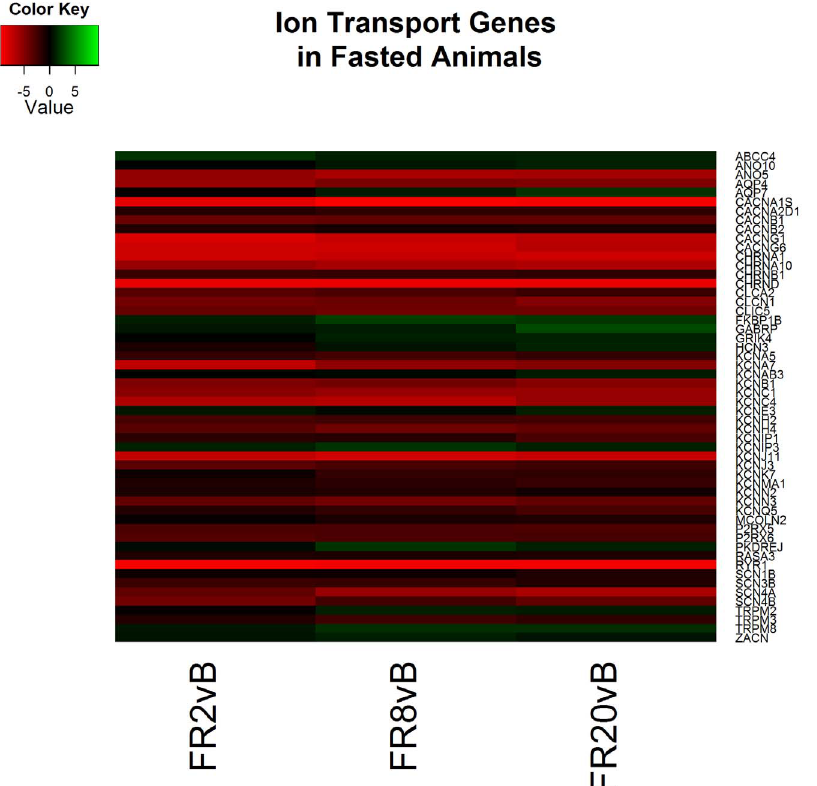
Figure 9. Heatmap of log2 fold changes of genes associated with ion transport in fasted (FS) animals at each resuscitation timepoint (2, 8, and 20 hours) relative to Baseline (B). Rows are differentially expressed genes (DEGs) following RNA sequencing. Columns denote the respective timepoints Baseline (B), 2 hours full resuscitation change from Baseline (FR2vB), 8 hours full resuscitation change from Baseline (FR8vB), and 20 hours full resuscitation change from Baseline (FR20vB). Green denotes increased mRNA expression with respect to Baseline whereas red denotes the opposite.